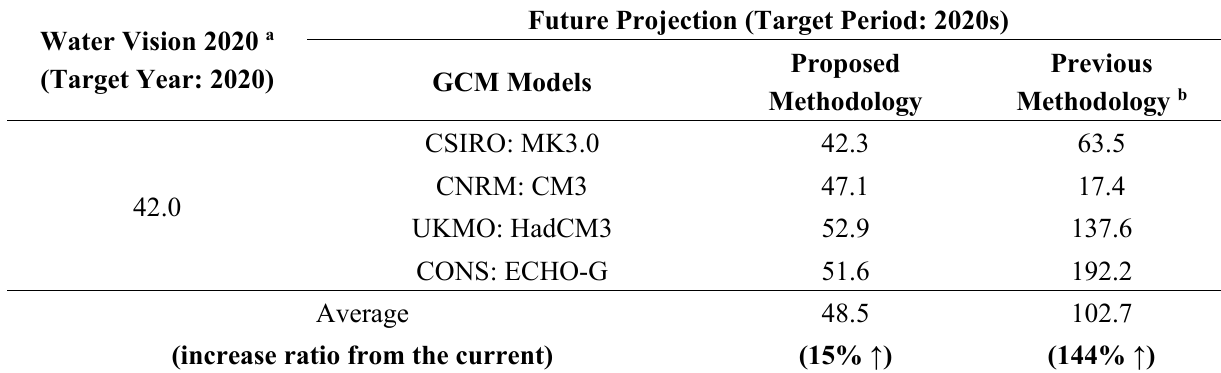
Table 4. The average water shortage projections for 2020s in the Han River basin (unit: 10 6 m 3